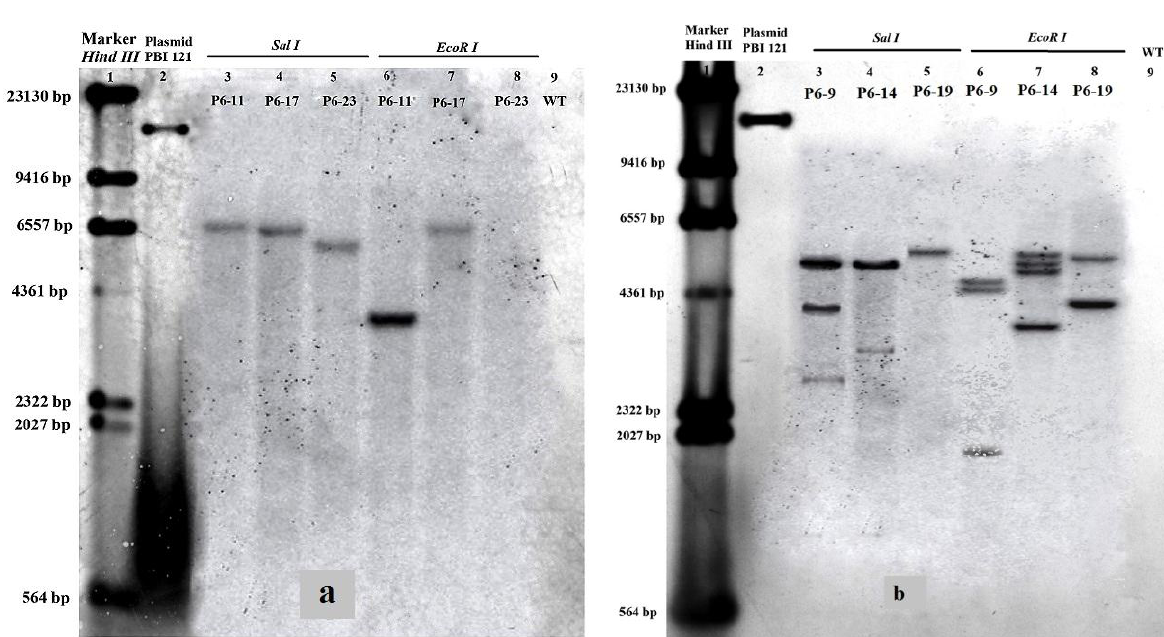
Figure 5. ( a ) Southern blot analysis of transgenic poplar lines generated without improved transformation efficiency. Genomic DNA extracted from three transgenic poplar lines was digested separately with Sal I and Eco RI and blotted onto a nylon membrane. The blots were probed with an 868-bp PCR fragment generated from CarNAC6 cDNA.